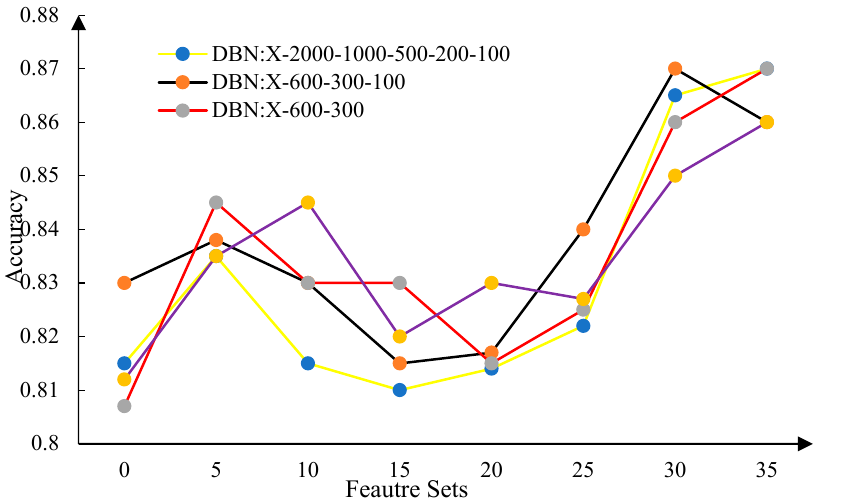
Figure 8. DBN: X600 classification standard rate.